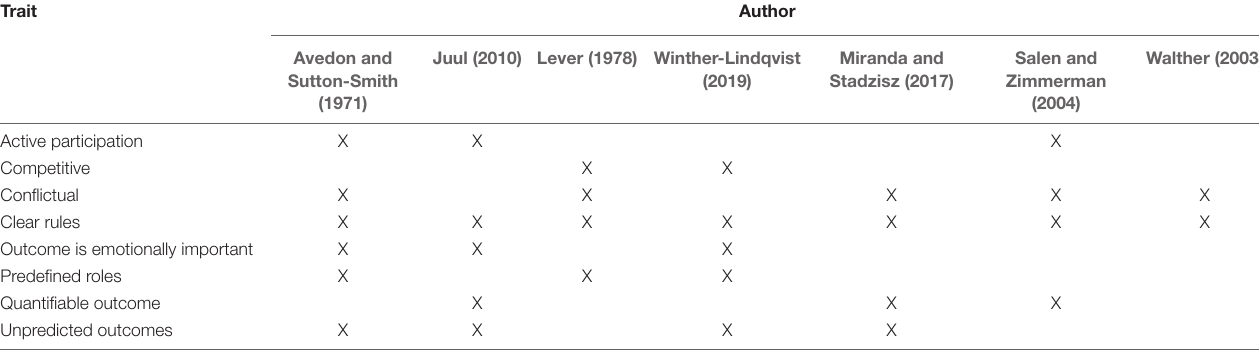
TABLE 2 | Traits presented in definitions of “game.”